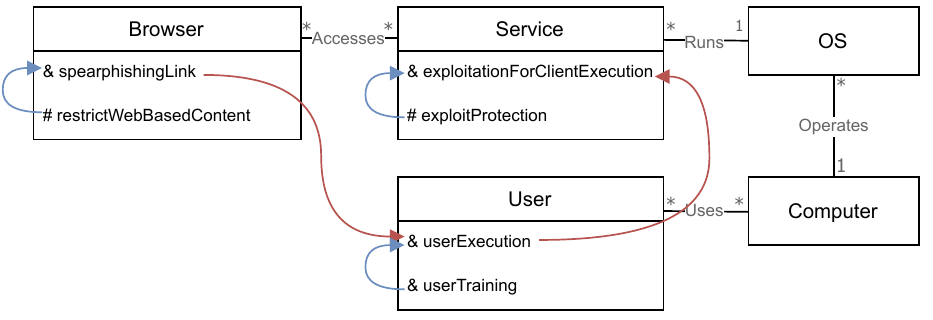
Figure 2. Graphical representation of attack steps and defenses relations